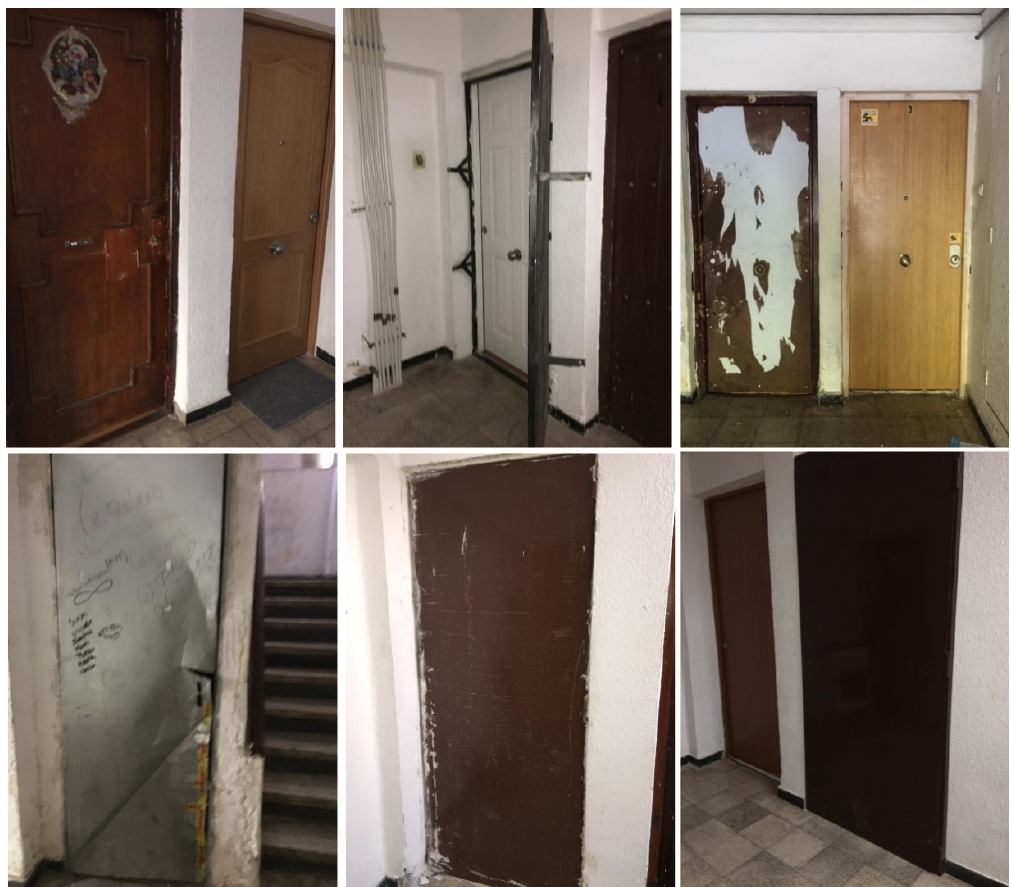
Figure 8. 1960s social housing development: neglected communal areas and inner courtyards, home with shuttered windows to deter squatters. Source: Prepared by the author (22 January 2021).